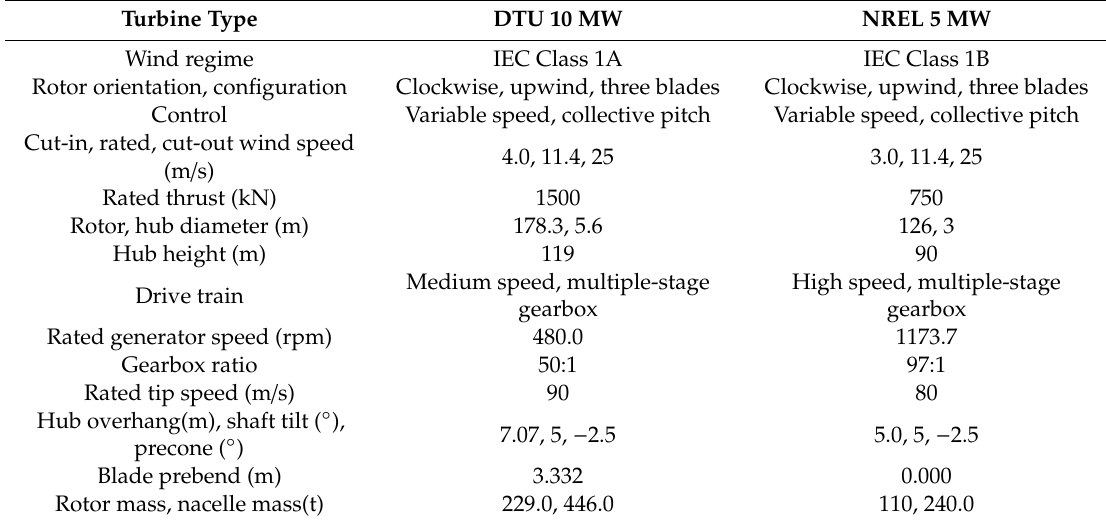
Table 1. Specifications of the wind turbine [20].